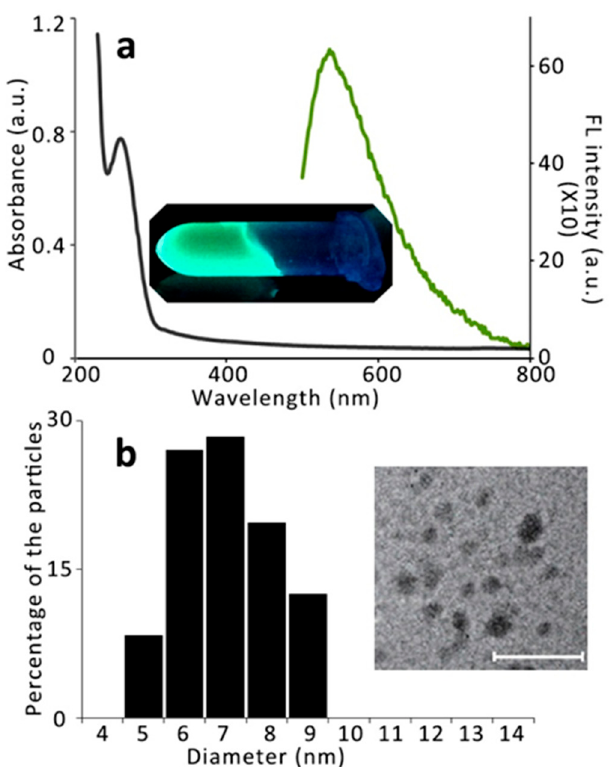
Figure 5. Characterization of extracted QDs (E:QDs). ( a ) Absorbance and fluorescence (FL) spectra are indicated by black and green colors, respectively. A photograph of the E:QDs under UV ( λ = 312 nm) light is shown in the inset. ( b ) DLS measurements and size distribution. The column chart indicates the size of E:QDs. The TEM image of the E:QDs is shown in the inset. The scale bar is 40 nm.